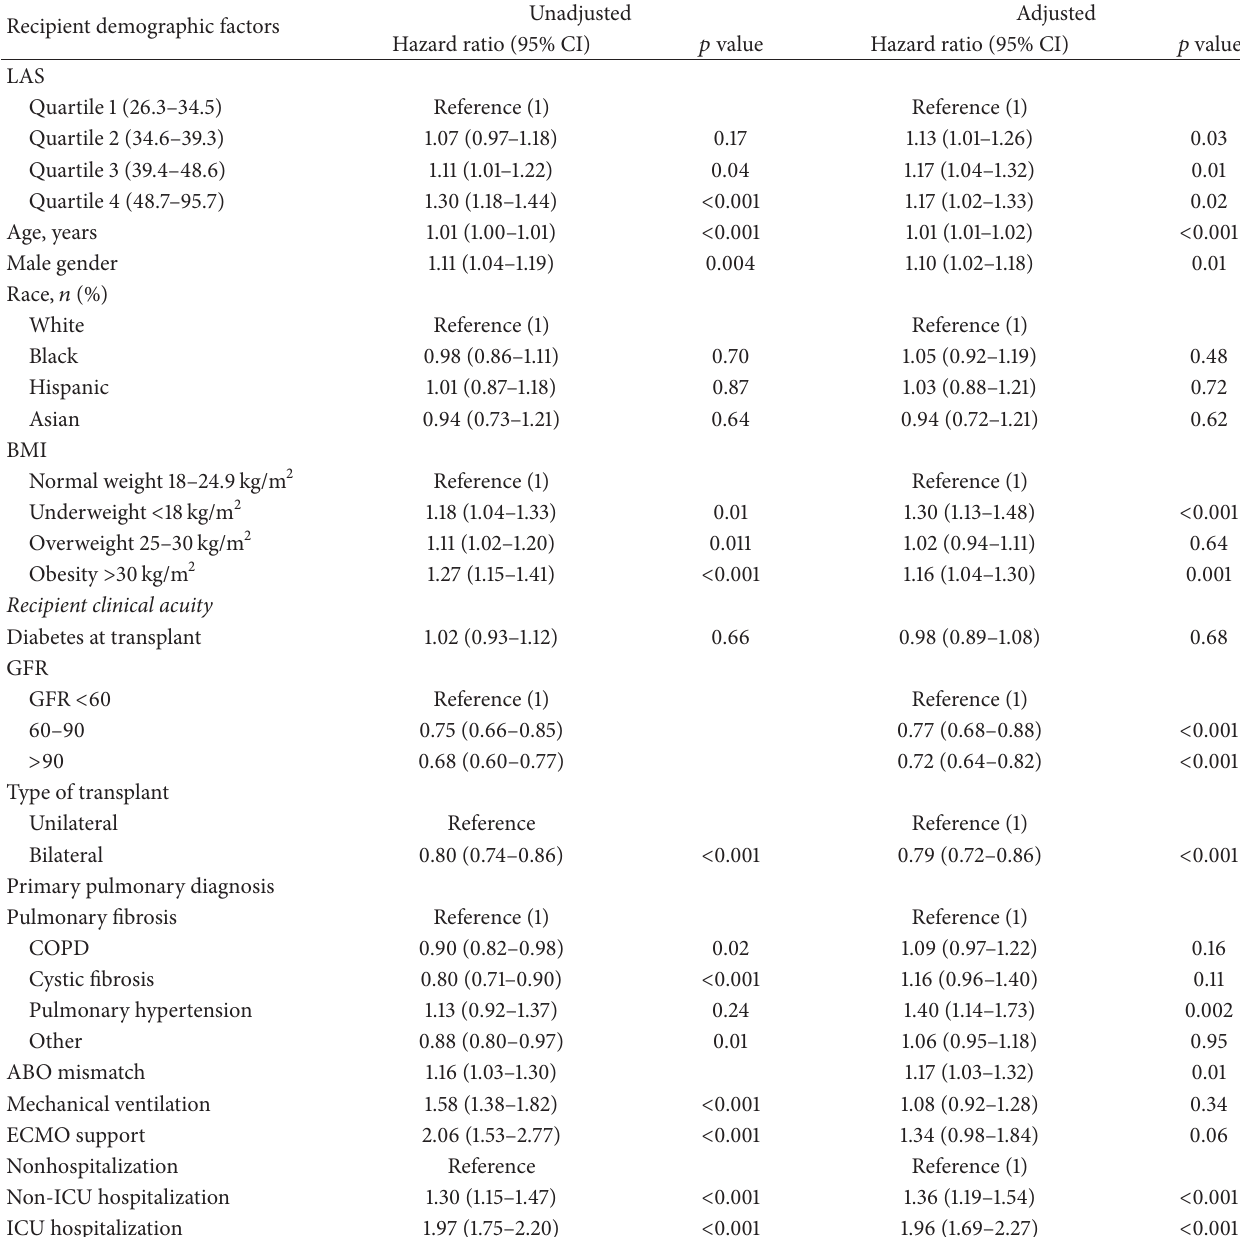
Table 3: Predictors of 5-year mortality after lung